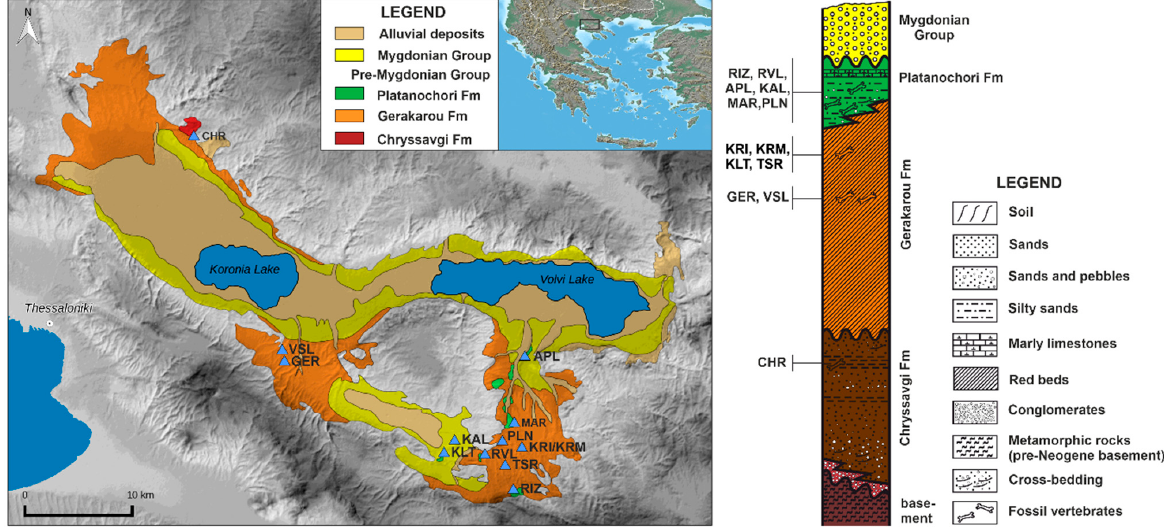
Figure 2. Geological map of the Neogene and Quaternary lithostratigraphic units of the Mygdonia Basin ( left ) and simplified composite stratigraphic column of the basin indicating the position of the fossiliferous localities ( right ). Modified from [21] and data from [19] . Map of Greece from Copernicus Land Monitoring Service (https://land.copernicus.eu/).